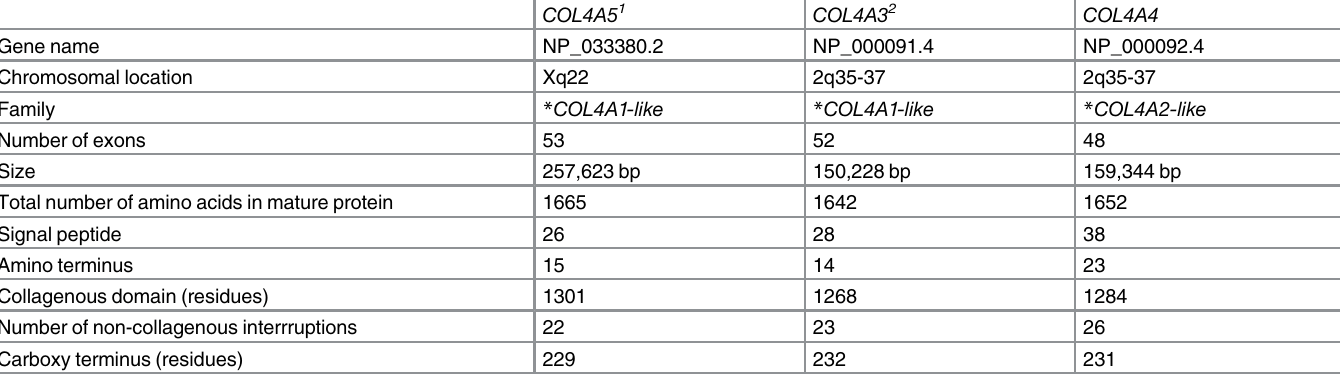
Table 1. Characteristics of COL4A5 , COL4A3 and COL4A4 genes and the corresponding